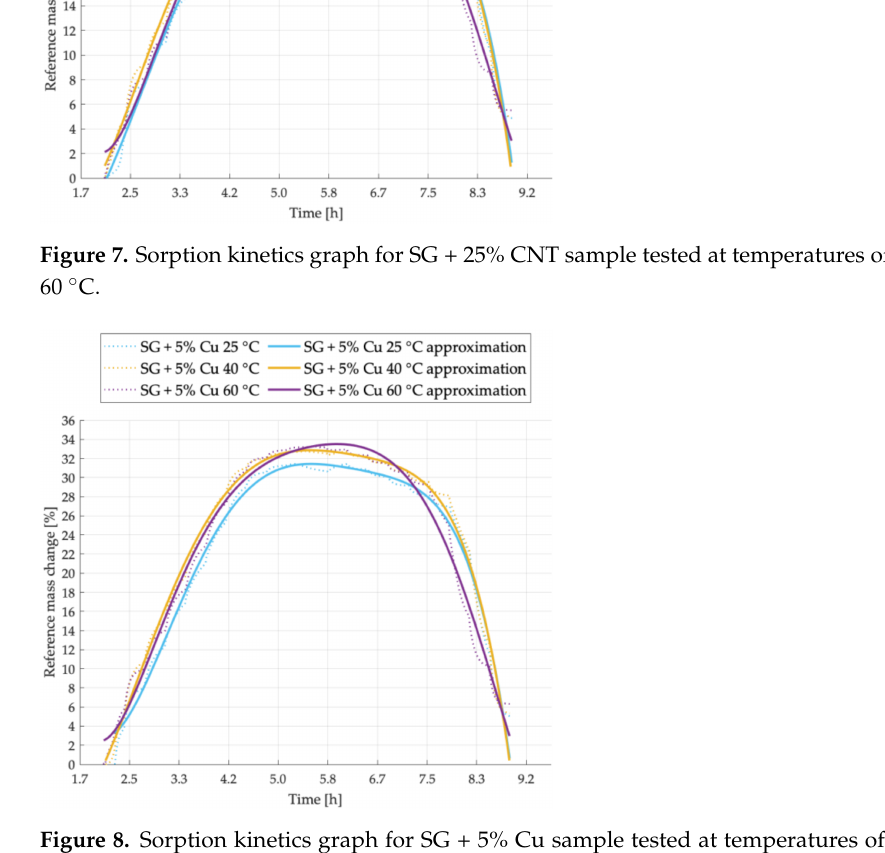
Figure 8. Sorption kinetics graph for SG + 5% Cu sample tested at temperatures of 25 ◦ C, 40 ◦ C, 60 ◦